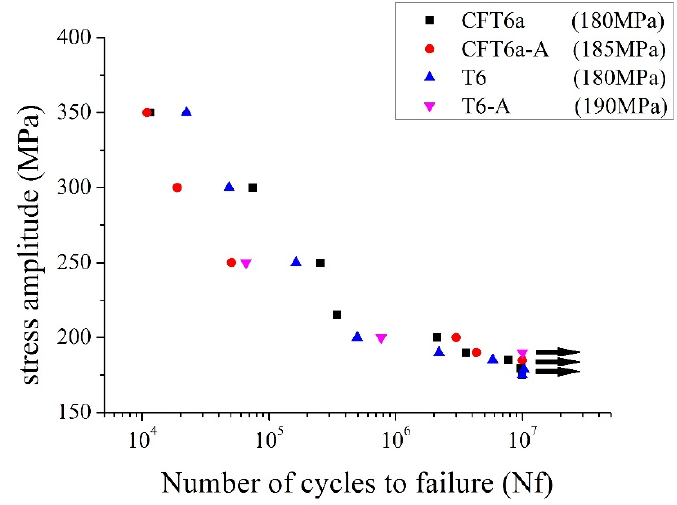
Figure 8. S–N curves for different samples; including T6 and CFT6a with/without anodization/sealed treatment; “A” represented anodization/sealed sample.